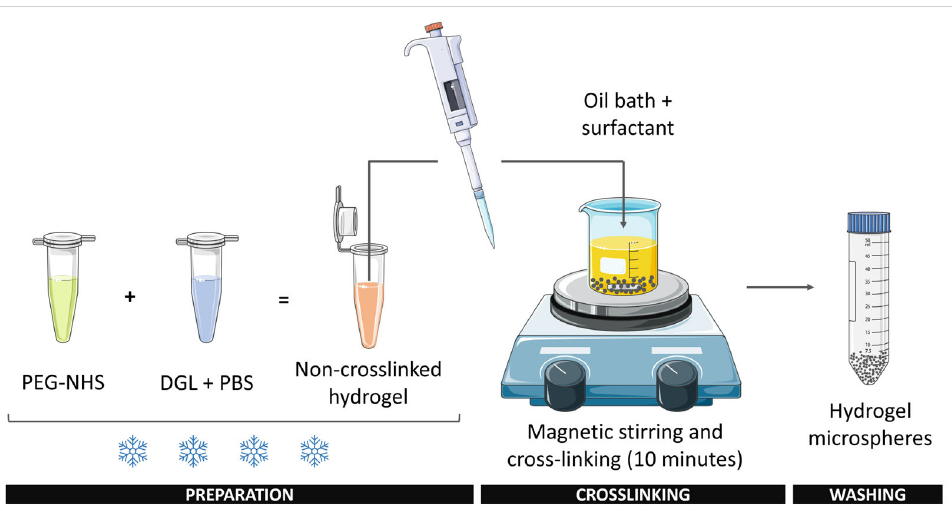
Figure 1. Representative sketch of the protocol used to prepare the DGL/PEG hydrogel microspheres. PEG-NHS was added to DGL prepared in PBS buffer on ice to inhibit the initiation of crosslinking. After vigorous homogenization on ice, the hydrogel is transferred to an oil bath containing the surfactant to allow crosslinking under magnetic stirring. After 10 min, the obtained microspheres are washed before